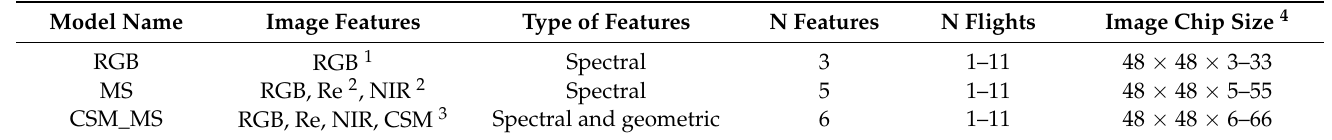
Table 1. Description of image features, number of flights, number of image features and dimensions of image chips for the three imaging approaches